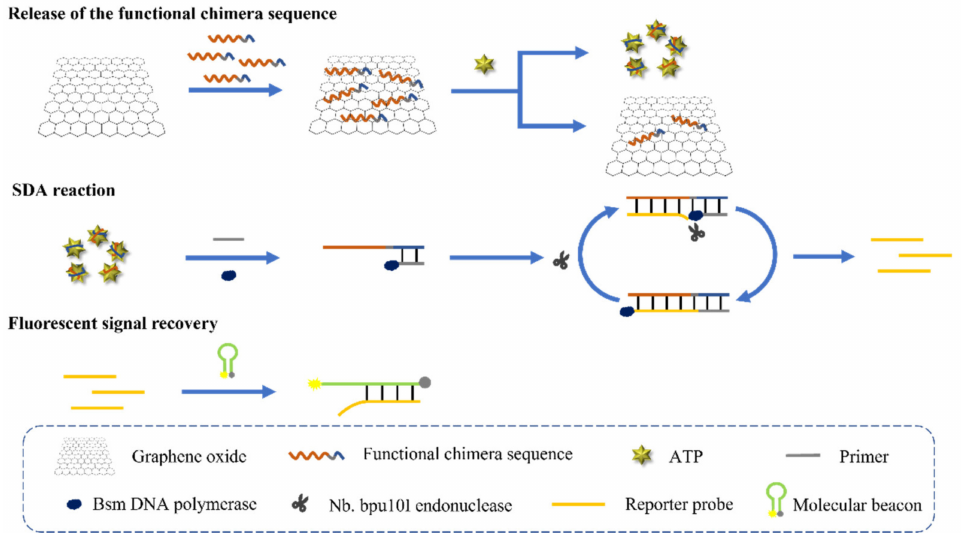
Figure 2. Schematic illustration of the fluorescence aptasensor for